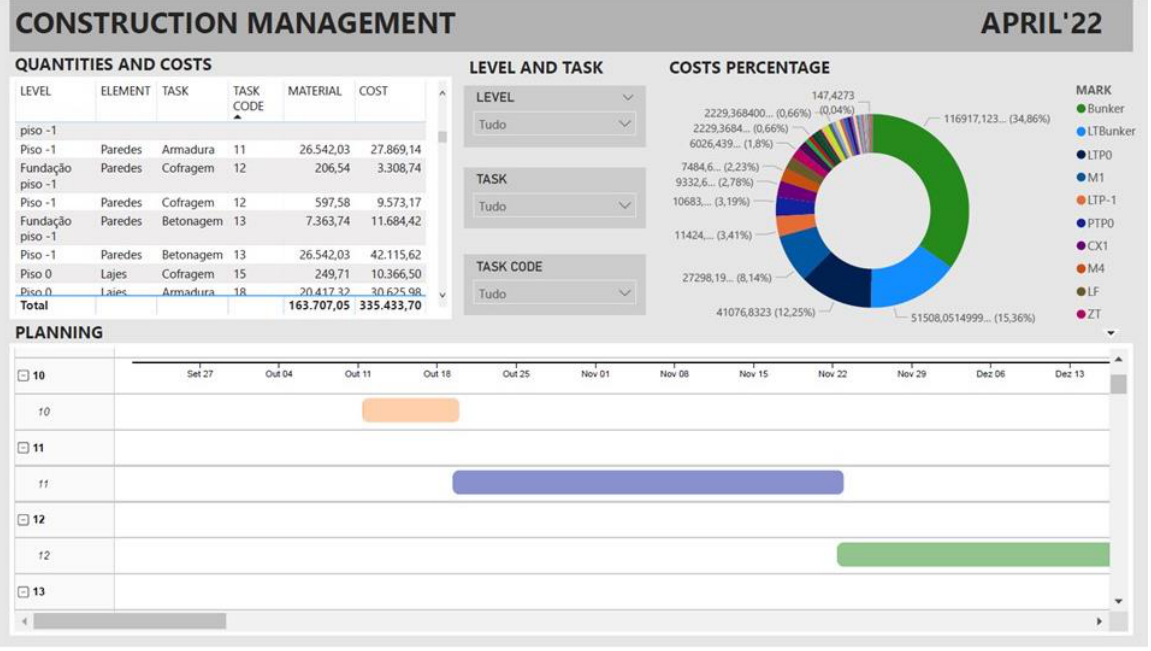
Figure 8. Power BI dashboards—all the construction works.